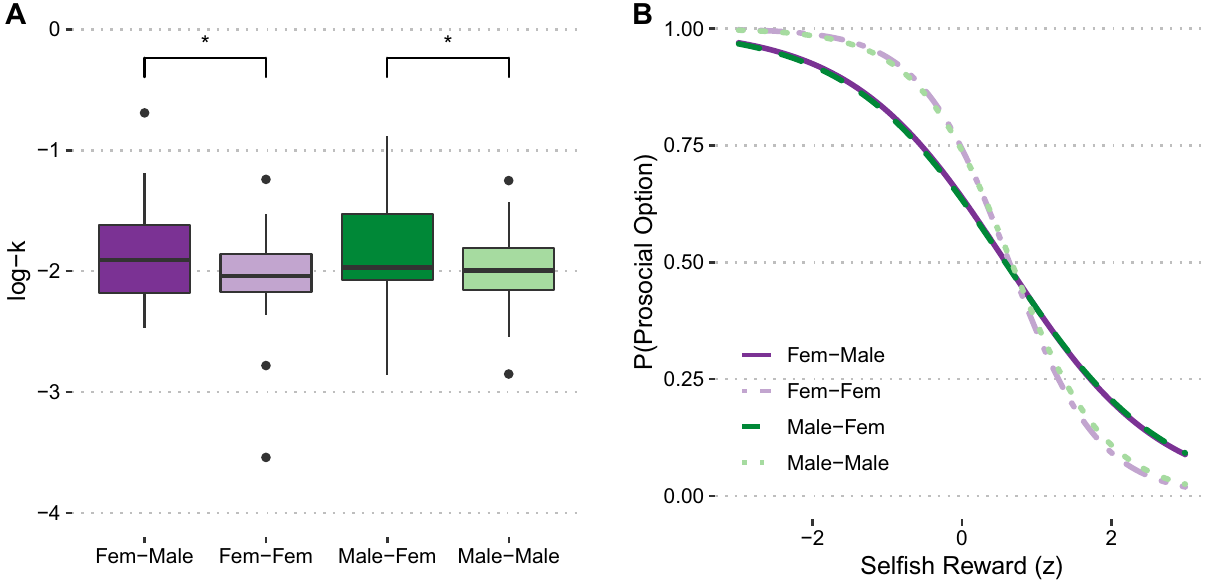
Figure 3. Interpersonal discounting task. ( A) Log-transformed estimated discount factors k social (log-k) by Sex and Group, median and interquartile ranges are displayed. A larger k reflects more selfish decisions with increasing social distance. ANOVA on log-ks revealed a significant difference for Group: Participants in different-gender avatars made less prosocial decisions with increasing distance than participants in same-gender avatars. ( B) The probability of choosing a prosocial option as a function of z -transformed magnitude of selfish reward is displayed. MGLM on predictors Sex, Group, Social Distance, and Selfish Reward, revealed a significant Group × Selfish Reward magnitude interaction: Participants in different-gender avatars were less sensitive to the magnitude of the selfish reward than same-gender